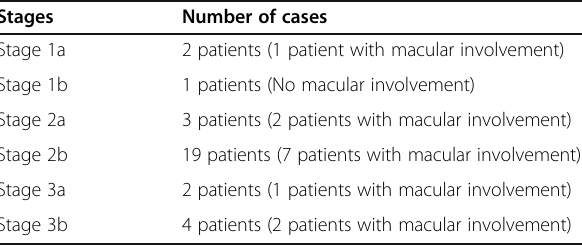
Table 3 Classification of cases according to Eales ’ disease classification system. (Eur J Ophthalmol 2004; 14: 236 –